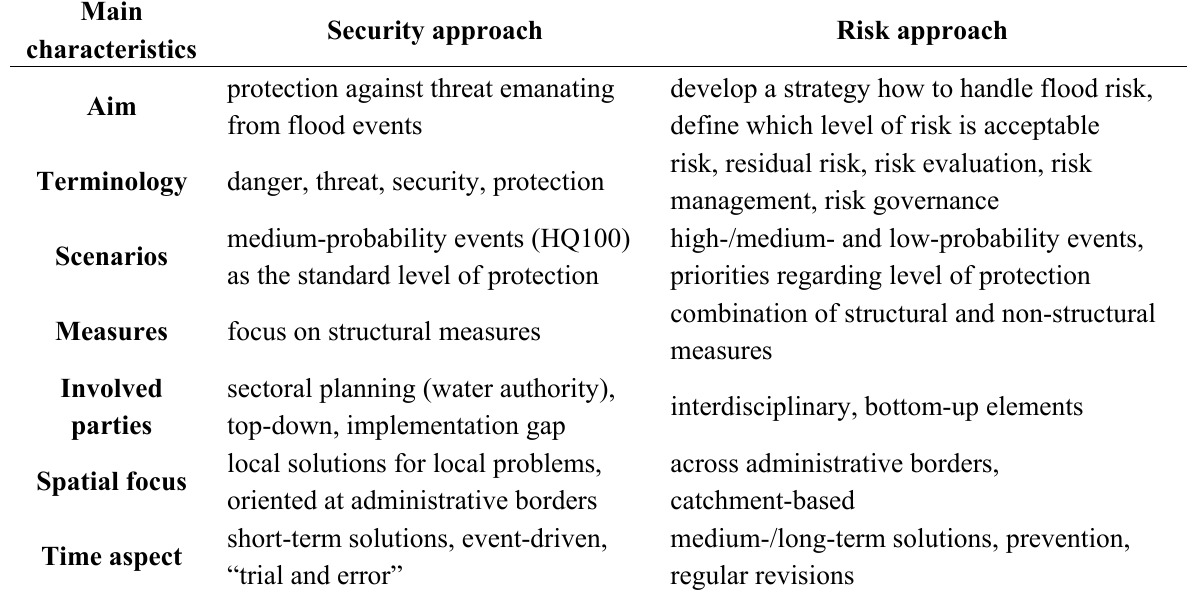
Table 1. Comparison of security approach and risk approach